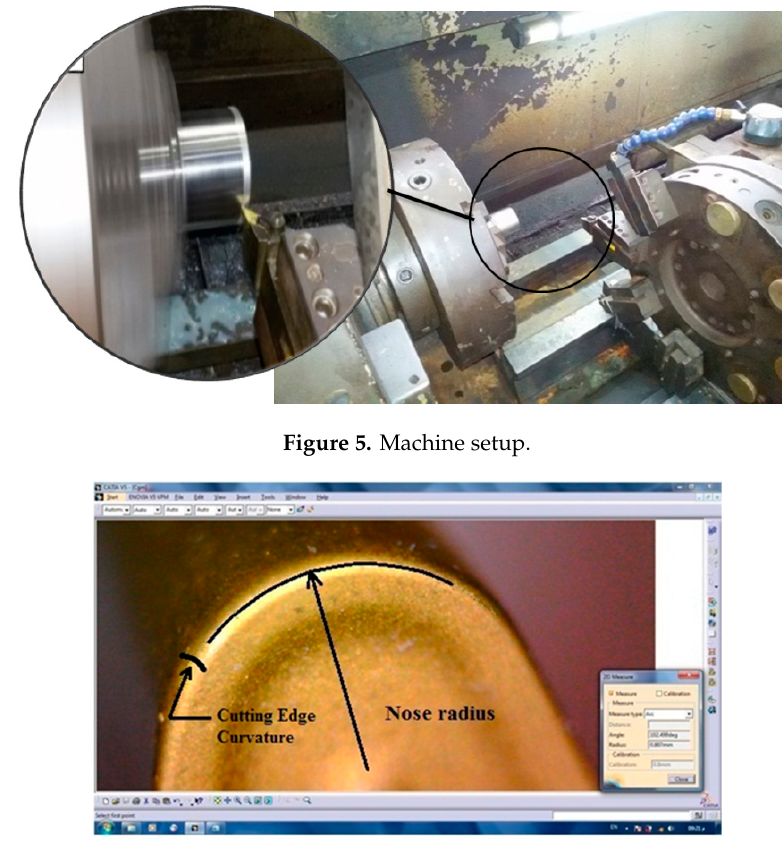
Figure 6. The cutting insert.